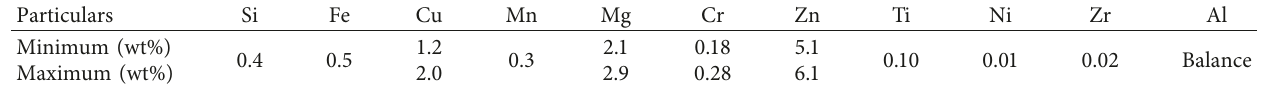
Table 1: Chemical arrangement of AA7075.